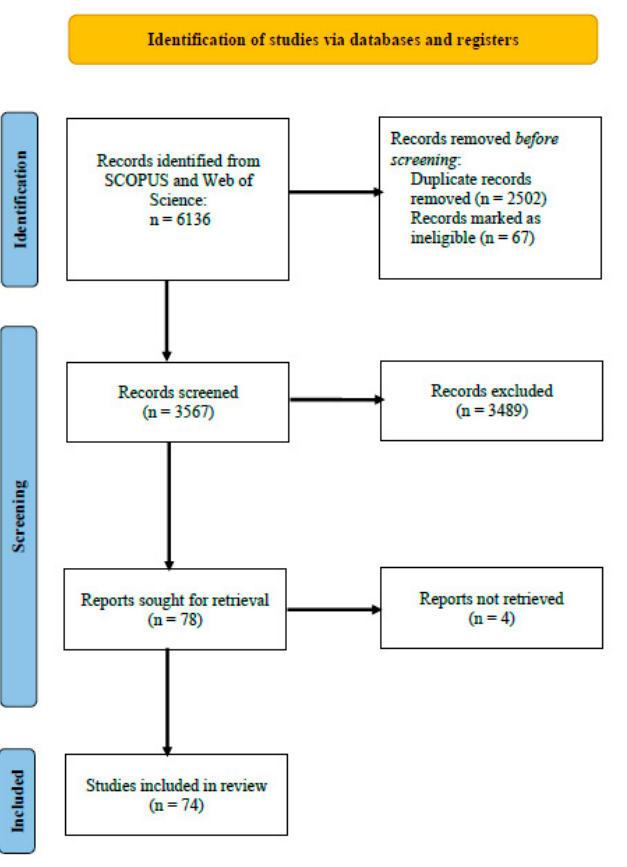
Figure 2. PRISMA flowchart reporting the article selection process for the systematic literature review.